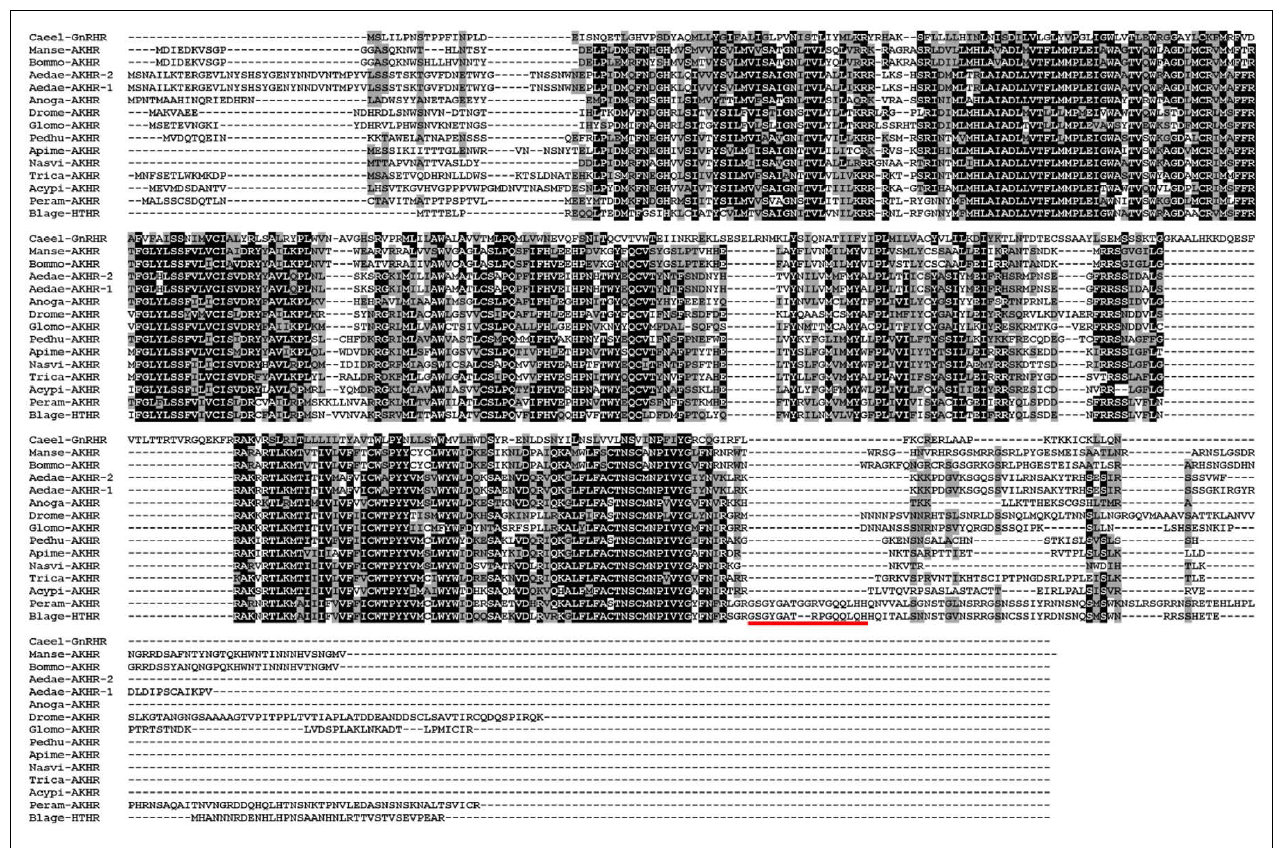
indicates the amino acids are identical among species, whereas a gray background shows similarity among residues.The red underline indicates the insertion present in both cockroach species.The abbreviated names of sequences used are provided in Figure 1B